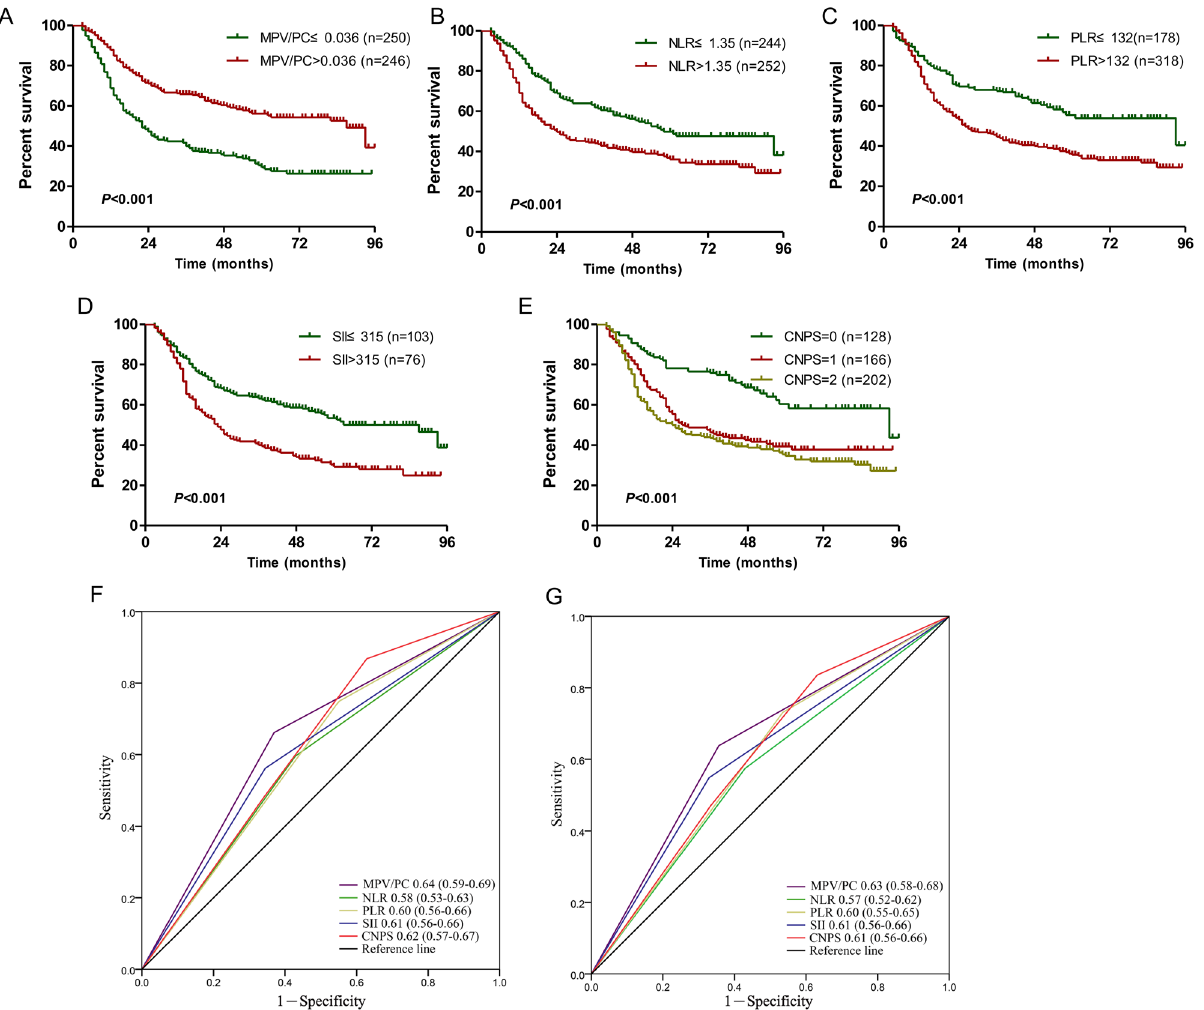
Figure 1. The prognostic significance of preoperative MPV/PC ( A ), NLR ( B ), PLR ( C ), SII ( D ), and CNPS ( E ) in gastric cancer in the primary cohort. Predictive ability of the MPV/PC in gastric cancer was compared with NLR, PLR, SII and CNPS by ROC curves in 3-years ( F ) and 5-years ( G ) in the primary